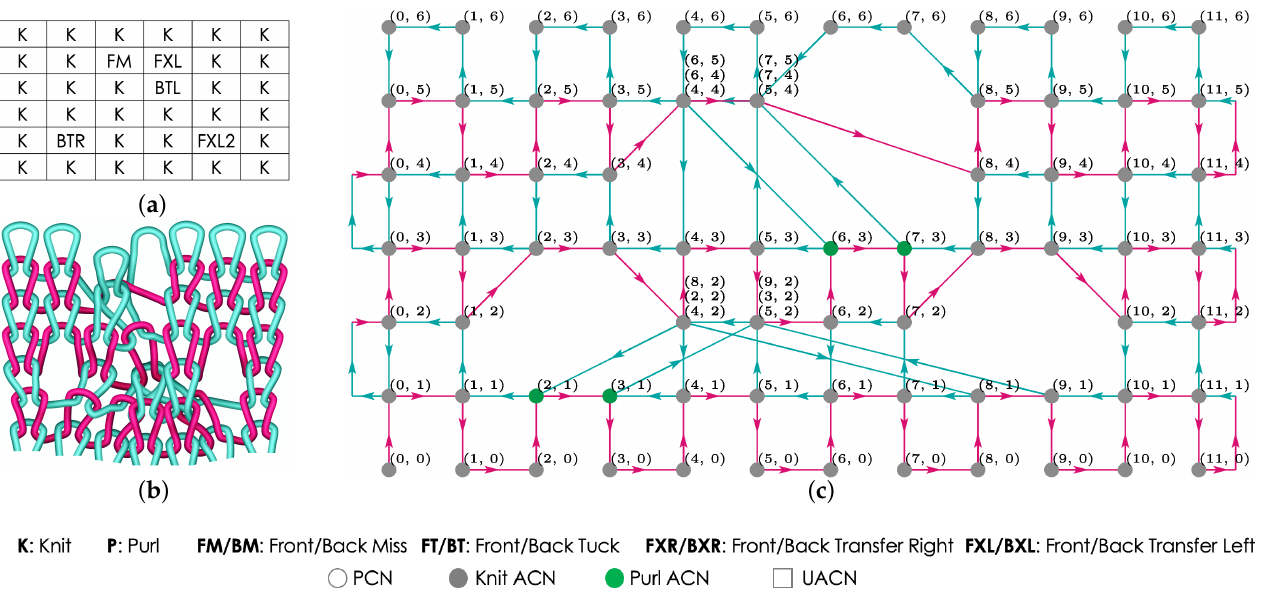
Figure 13. Stitch pattern with a combination of Knit and Front and Back Transfer stitches: ( a ) Stitch instructions. ( b ) Simulated knitted pattern. ( c ) Topology graph displaying CN (loop) order.